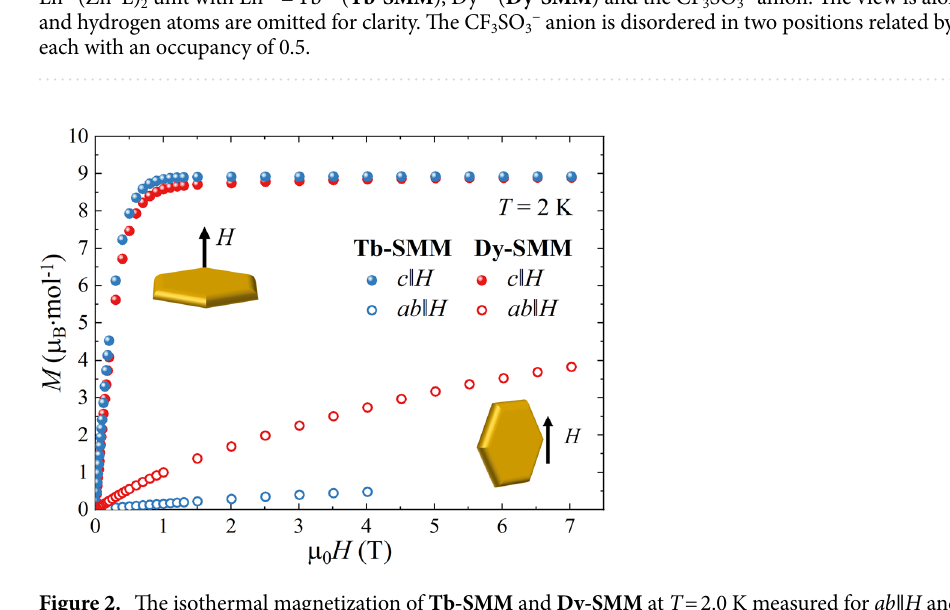
(Fig. 1b). A crystallographic three-fold axis passes through the Zn–Tb–Zn array and is parallel to the crystal- lographic c axis. Three two-fold axes are located on Ln III = Tb III /Dy III central ion and are perpendicular to the C 3 axis, and hence the molecule belongs to the D 3 point group symmetry. The coordination sphere around the Ln III = Tb III /Dy III ion is fully occupied by 12 oxygen atoms, with the short-bonded phenoxo oxygen donors (2.3651(19) Å for Tb-SMM and 2.3437(19) Å for Dy-SMM ) at above and below positions and long-attached methoxy oxygen donors (3.0465(15) Å and 3.076(2) Å) located at the equatorial positions. Obtained single crystals were flat and formed the hexagonal-like shape with the crystallographic axis c being perpendicular to the surface of the crystal and ab crystallographic plane lying in the plane of the surface (Fig. 1a). Single crystal magnetometry measurements of Tb-SMM and Dy-SMM were performed within the ab plane ( ab ∥ H ) and along the c axis ( c ∥ H ). Figure 2 shows the isothermal magnetization M ( H ) of Tb-SMM and Dy- SMM at T = 2.0 K. In both samples, the c || H is the easy magnetization direction, with saturation magnetization M S ≈ 8.9 µ B mol −1 . The crystal field calculation for Tb-SMM 36 revealed that in a non-zero magnetic field the lowest lying states of Tb 3+ ions display maximal values of (cid:31) J z (cid:30) = ± 6. Taking into account g Tb = 3/2, the expected value of saturation reaches 9 µ B mol −1 , which is close to the measured M s . In the case of Dy-SMM the crystal field analysis 37 revealed that the ground state of the Dy 3+ ion is degenerated and corresponds to the |± 13/2 〉 substates, which points to ≈ 8.7 µ B mol −1 for g Dy = 4/3. The ab crystallographic plane is the hard magnetization plane with maximum values of 0.5 µ B mol −1 (≈ 6% of M S ) for Tb-SMM at µ 0 H = 4 T and 3.8 µ B mol −1 (≈ 43% of M S ) for Dy-SMM at µ 0 H = 7 T.